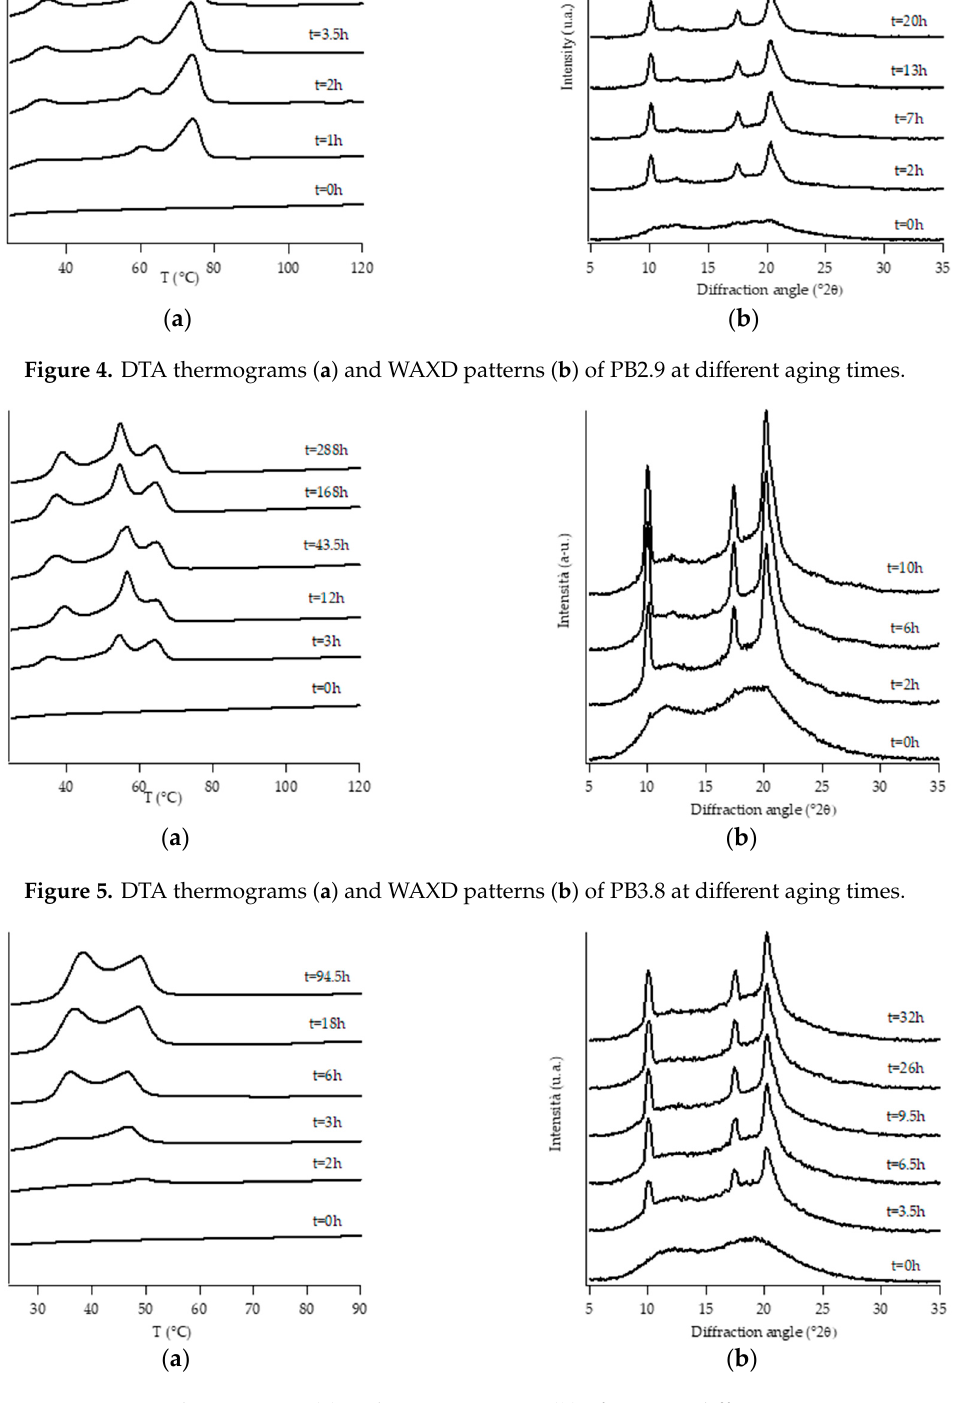
Figure 6. DTA thermograms ( a ) and WAXD patterns ( b ) of PB6.8 at different aging times.